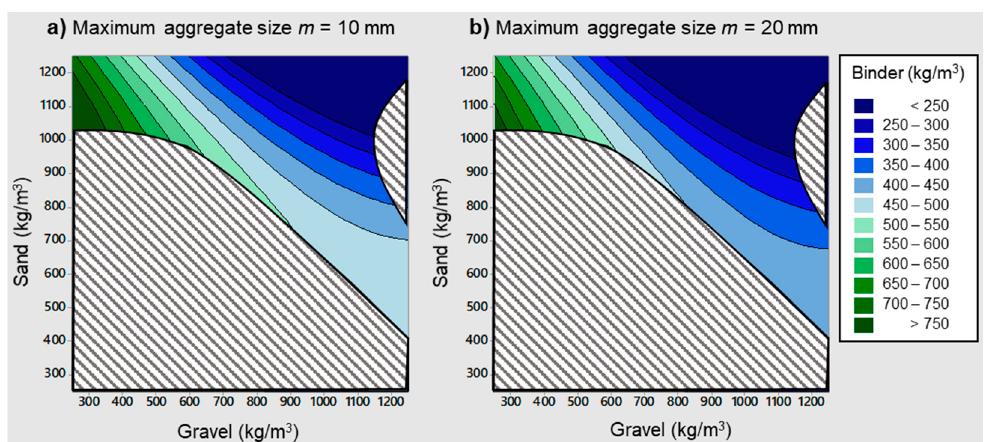
Figure 6. Binder content versus fine and coarse aggregate contents.